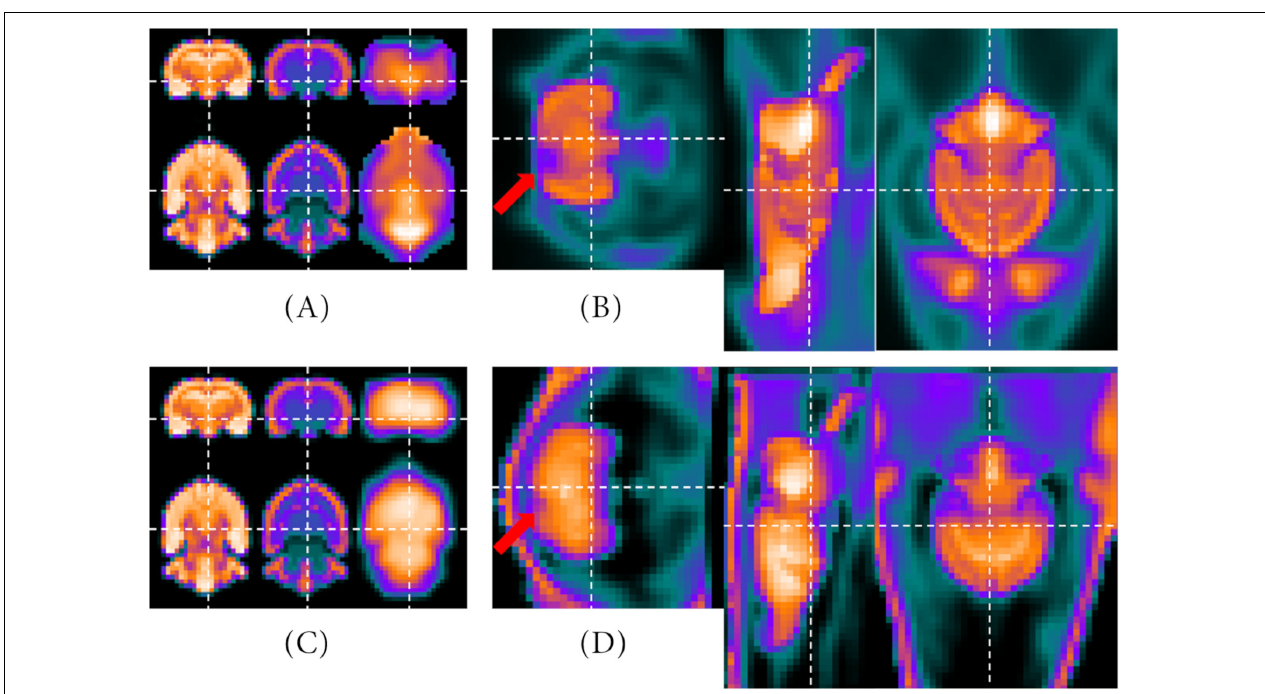
FIGURE 7 | Results of the co-registration processes. The upper row represents the optional 2nd PET template which is averaged out of (ii) 10 Wistar rats with ischemic stroke ([ 18 F]FDG) aligned with the representative MRI images. On the left side, the MRI T2* and atlas of the Wistar rat brain (Johnson et al., 2012) as well as the VOI of the optional 2nd PET template are presented (A) . On the right side, the MRI atlas is included in the image of the optional 2nd PET template (B) . The bottom row shows the same images (C,D) , but with the [ 68 Ga]Ga-Fucoidan data [(iii) 14 Wistar rats with stroke lesion] instead of the optional 2nd PET template. Here, the VOI is shown in the intensity-inversed representation, whereas the PET template is not. The red arrows mark the regions affected by the